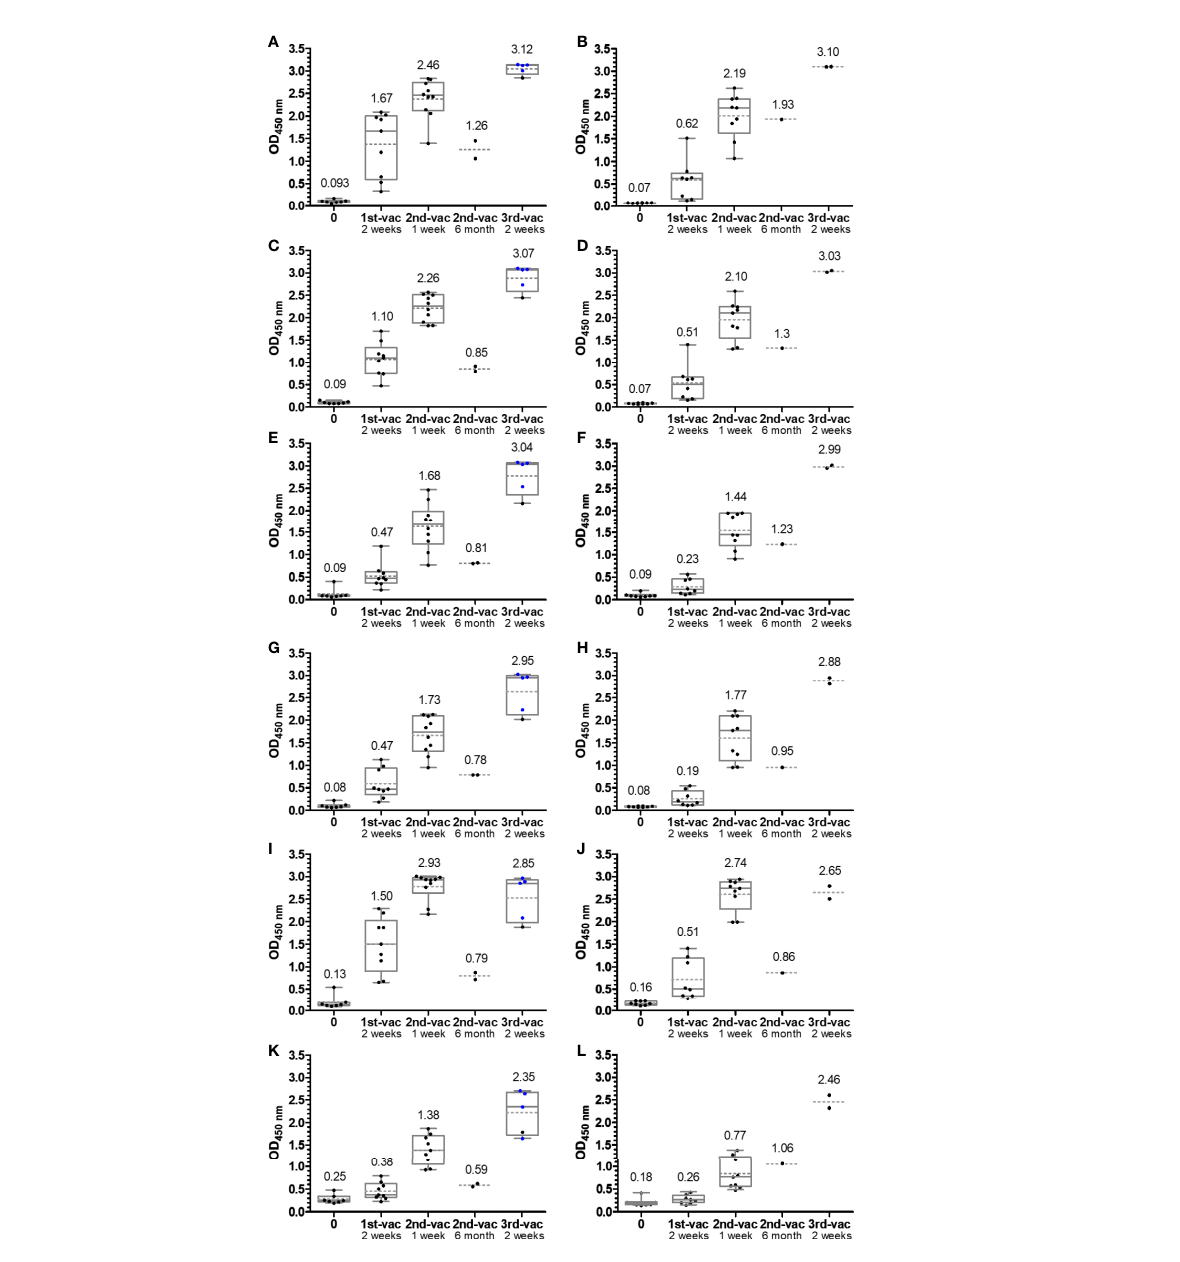
FIGURE 2 | Box plots of the OD 450 values obtained in an anti-RBD IgG ELISA using wild-type (A, B) , alpha (C, D) , beta (E, F) , gamma (G, H) , delta (I, J) , and omicron RBDs (K, L) . Serum or plasma samples were obtained from people vaccinated with mRNA-1273 (left panels A, C, E, G, I, K ) or BNT162b2 (right panels B, D, F, H, J, L ). Sera collected from people with heterologous booster vaccinations (2× mRNA-1273 and once BNT162b2) are indicated as blue dots. The median values are provided above the boxes and are additionally indicated as gray horizontal lines in the boxes, while the mean values are shown as gray horizontal dotted